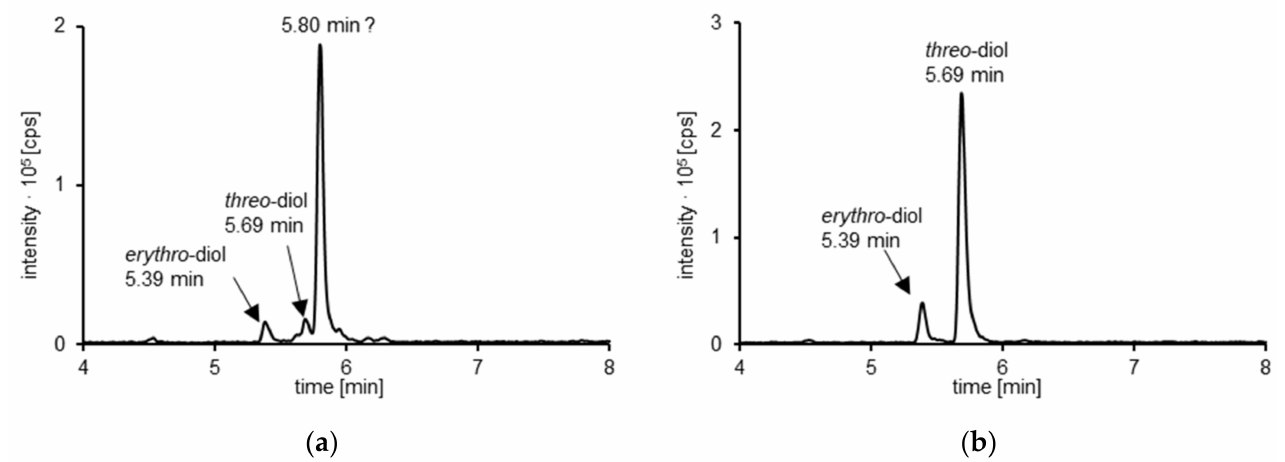
Figure 4. HPLC-MS/MS chromatogram of a randomly selected urine sample, which was given after consumption of a calamus tea infusion, ( a ) before; ( b ) after treatment with